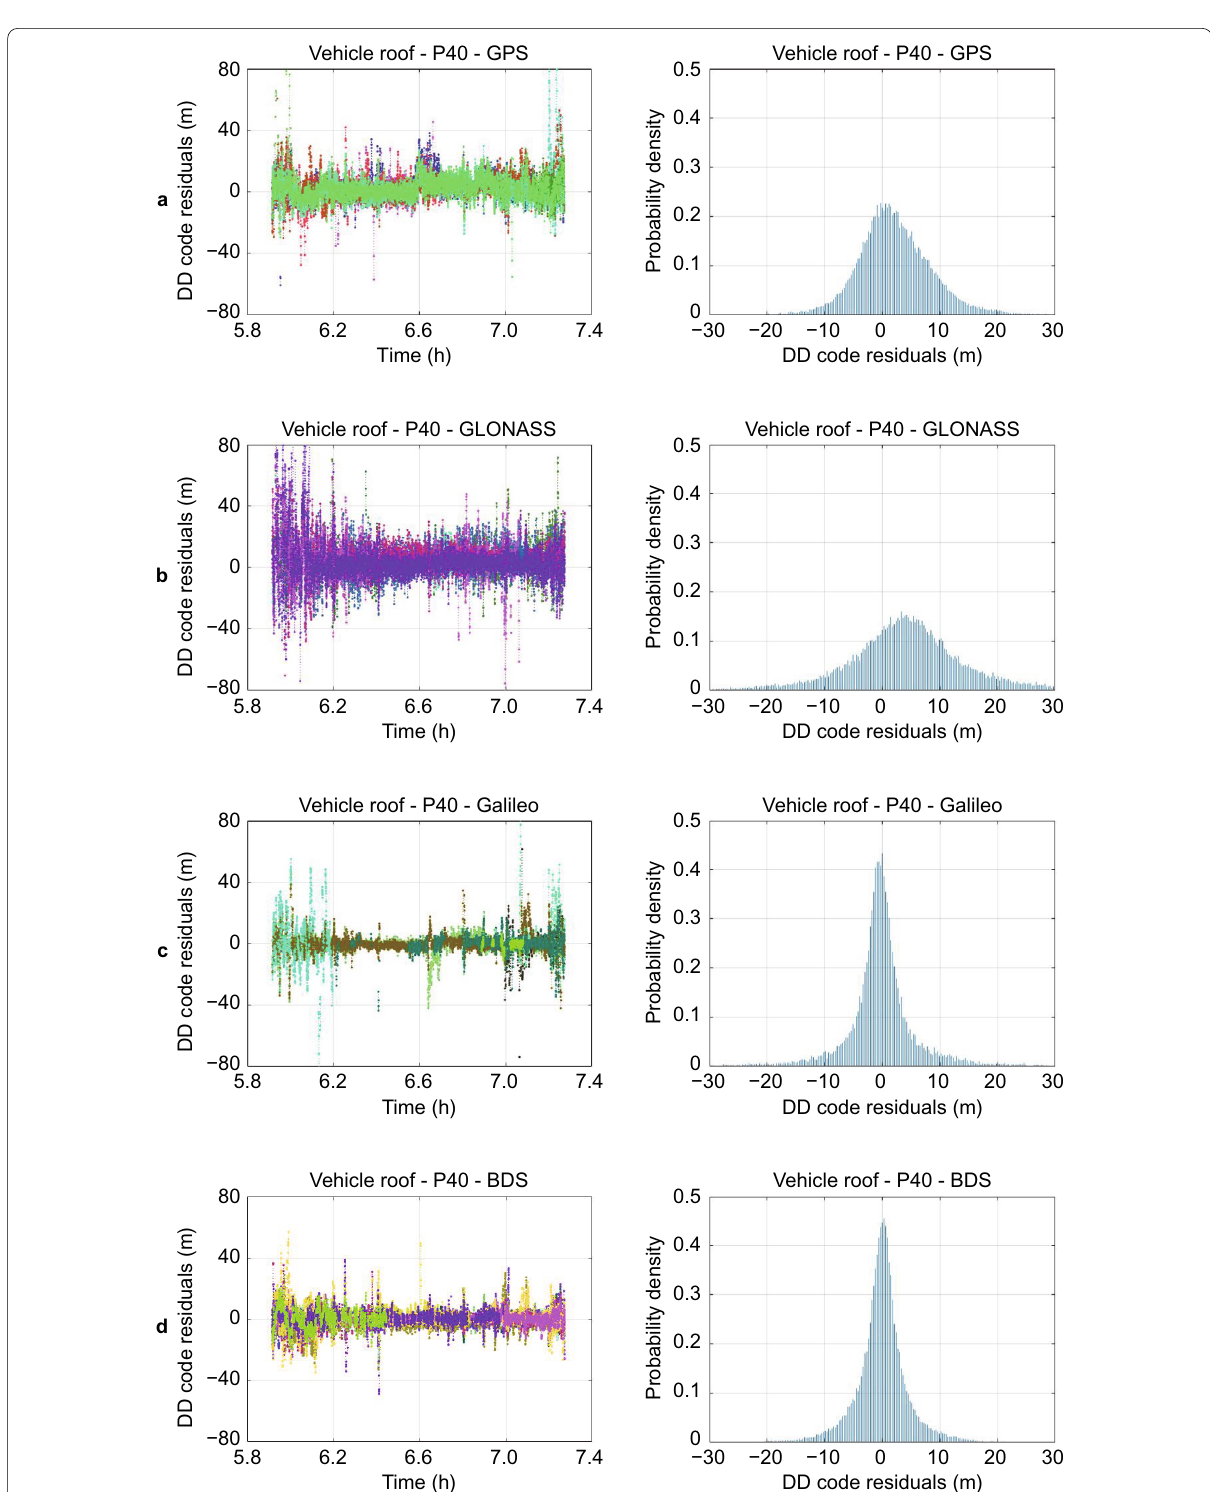
Fig. 4 Time series and probability density distribution of double-differenced (DD) code residuals on the first frequency band for the P40 smartphone in the vehicle-roof mode: a GPS L1, b GLONASS L1, c Galileo E1, and d BDS